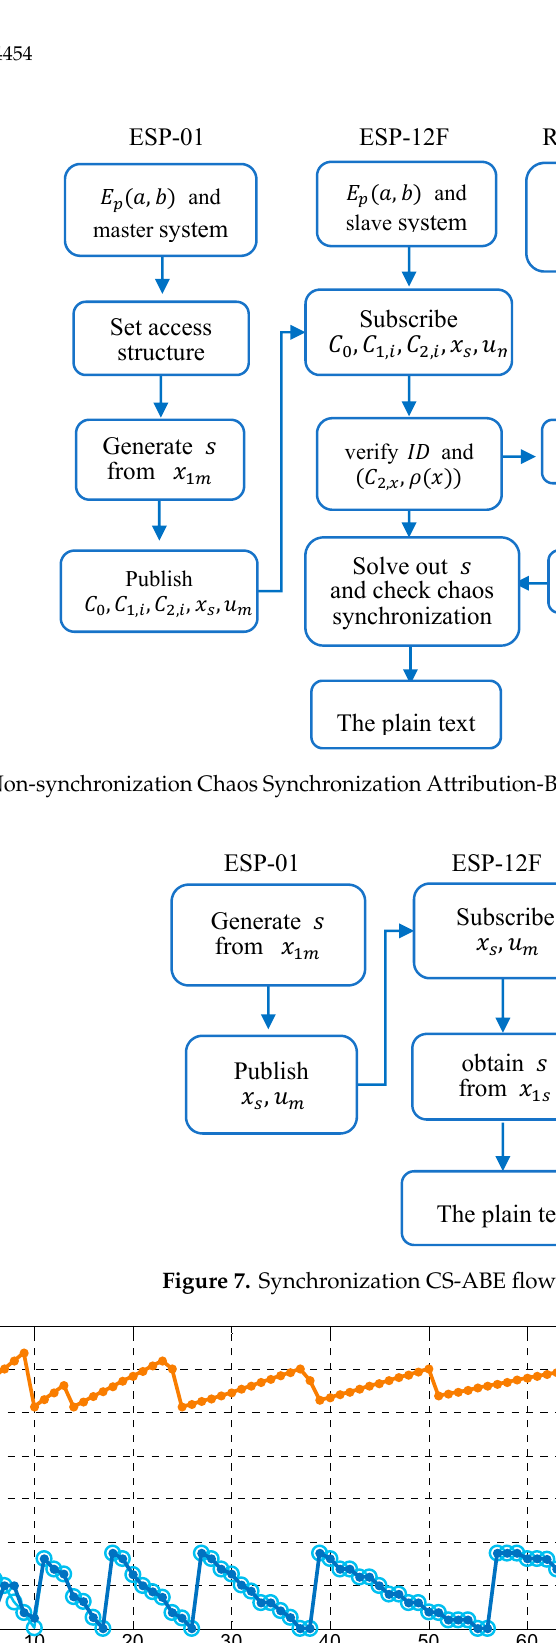
Figure 8. MQTT-SPY Figure 8. MQTT-SPY analysis. Figure 8. MQTT-SPY analysis.